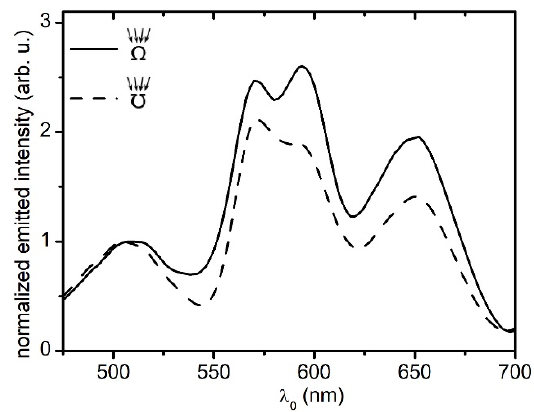
Figure 6. Spectral resonances of the resolved peaks (RP)-MSPRS from Figure 5b when excited by end- fire coupling configuration (continuous line) and Kretschmann-like configuration (dash